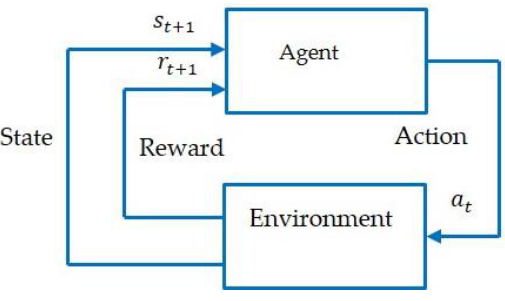
Figure 3. Reinforcement learning.